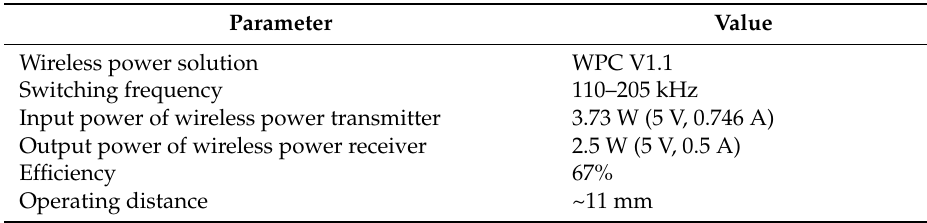
Table 6. Characteristics of the wireless power